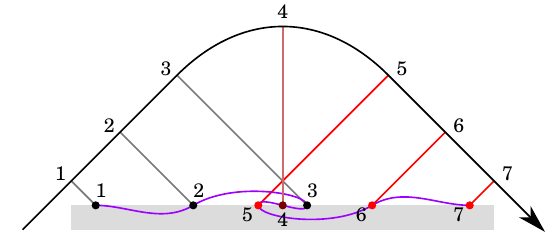
Figure 3: The regular mesh in ( τ, Θ) space, folding on itself in the ( x, y ) space.